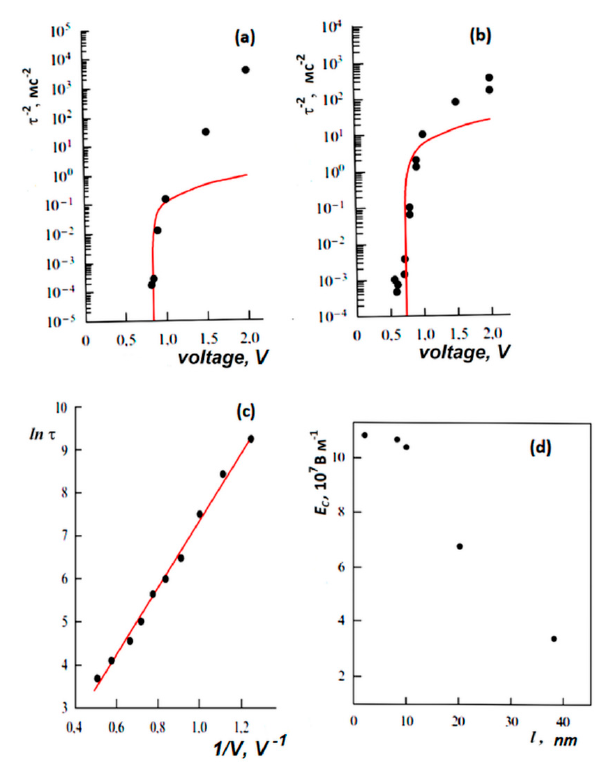
Figure 6. The dependence of the switching time τ on the applied voltage for 8-nm-thick BaTiO 3 film [1,3,22]: ( a ) in the capacitor and ( b ) in the probe mode in an atomic force microscope (lines τ − 2 (V) on ( a ) and ( b ) correspond to the calculations according to formula (7)); ( c ) for a BaTiO 3 crystal, the line corresponds to ln[ τ (V − 1 )] and is obtained relying on the piezo-response mode in an atomic force microscope; ( d ) the dependence of the coercive field on the thickness of the BaTiO 3 film. Reproduced with permission from [22]; Elsevier, 2013.